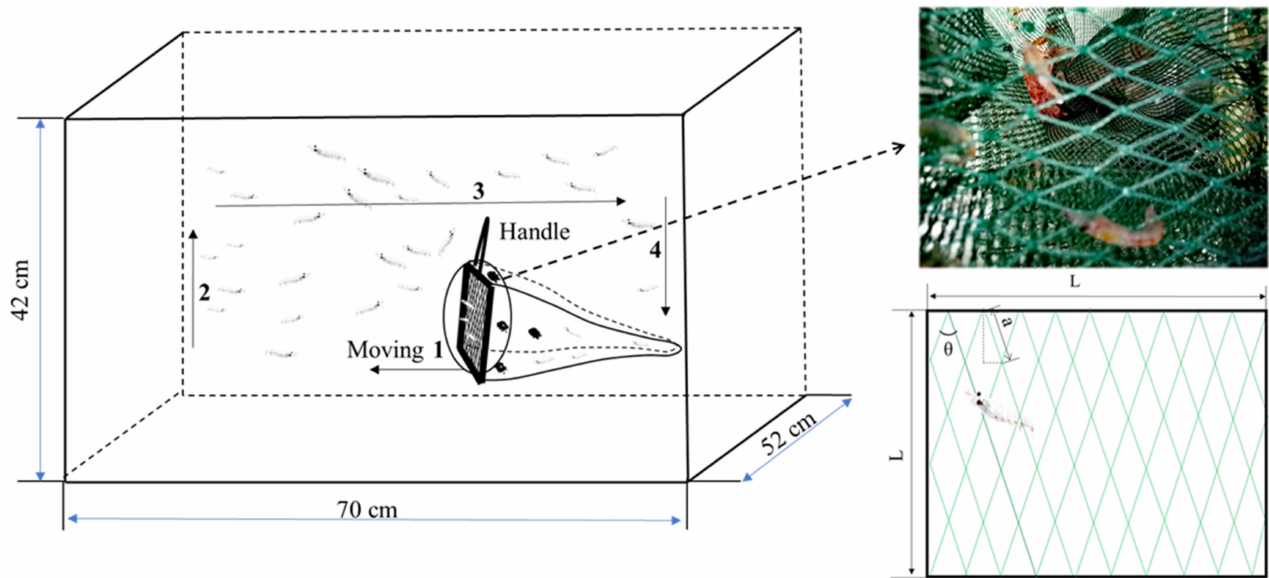
Figure 1. Schematic representation of an experimental trial, water tank and the experimental panel. The action simulating the krill trawling in the micro-cosmos experiment is decomposed into movement 1 and 2 arrows. The movement 1 arrow depicts the horizontal trajectory of the experimental panel (“trawling”) whereas the movement 2 arrow shows when the experimental panel was taken out of the water to continue with the 5-min reciprocating movement simulating trawling for krill.